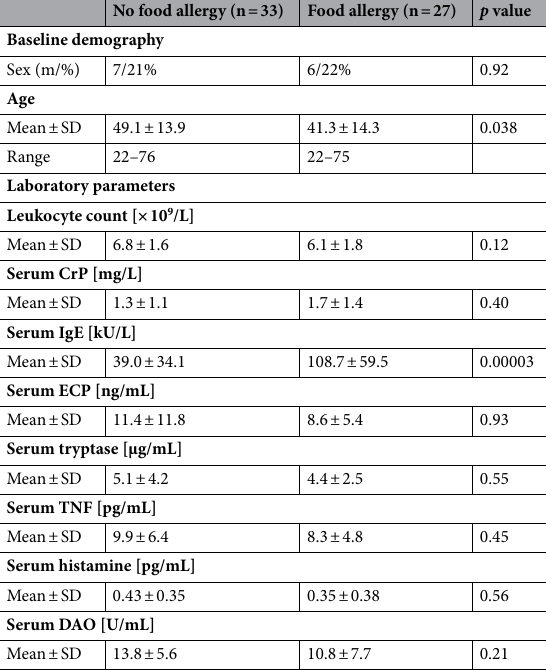
Table 1. Clinical characteristics of the patient cohort.